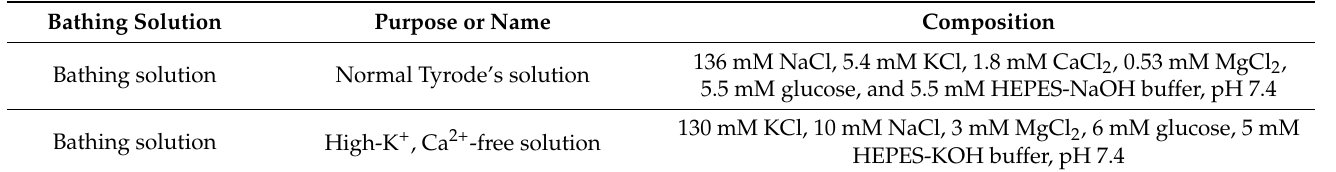
Table 1. Composition of normal Tyrode’s solution and the pipette solution used in this